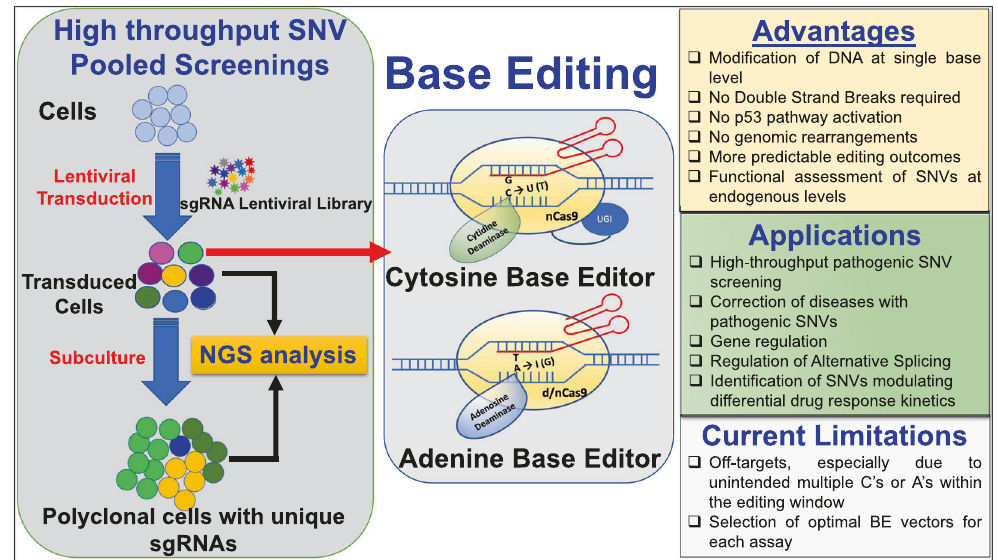
Fig. 1 Schematic overview of BE based high-throughput SNV pooled screening methodology; Advantages, therapeutic applications and current limitations (NGS: Next Generation Sequencing; SNV: Single Nucleotide